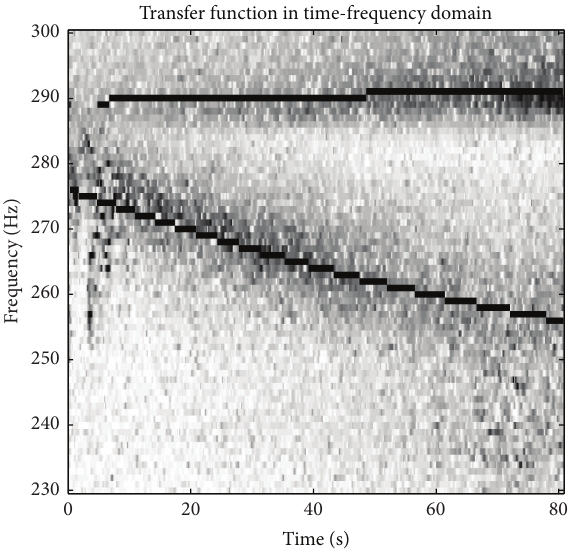
Figure 12: Experimental results obtained for the white noise excitation in the combined time-frequency domain.